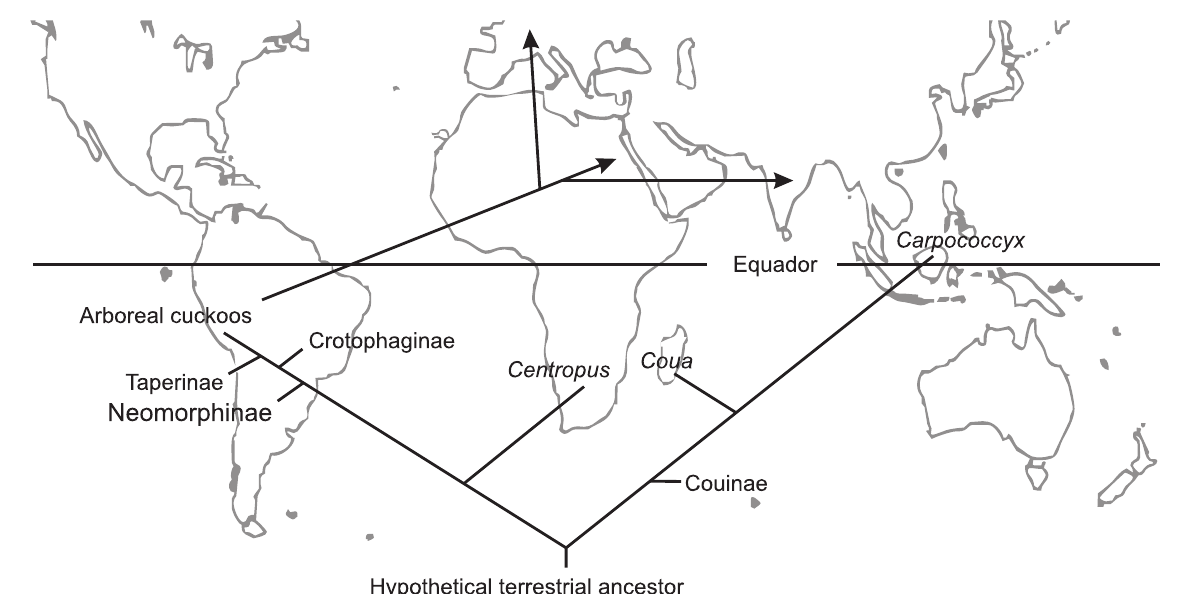
Figure 5. Current distribution of the basal cuckoos resulted from the Gondawanaland fragmentation (vicariance hypothesis). The later dispersion of arboreal cuckoos is shown in the line